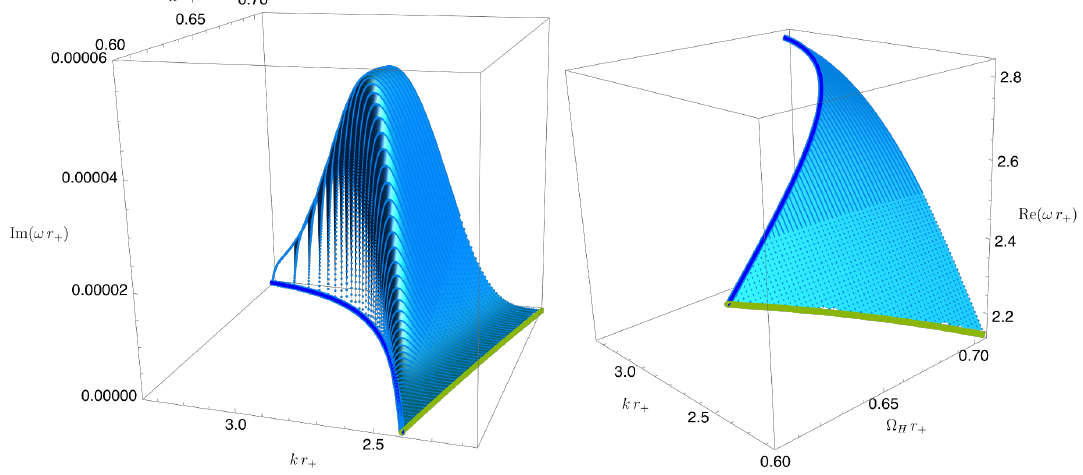
Figure 4 . Frequency for m = 2 unstable superradiant modes, as a function of parameters of Myers-Perry black strings. The instability is present (i.e. Im e Ω H | c = 3 / 5 , and e k ? ( e Ω H ) ≤ e k ≤ e k (0) ( e Ω H ) . The critical curve e k (0) ( e Ω H ) (and Im e ω = 0 ) was also computed independently in figure 3 and we show it as a continuous blue line in the Im On the other hand, the green curve represents the line e k ? ( e Ω H ) as defined parametrically in (4.12). It meets the merger blue curve at e Ω H | c = 3 / 5 . The Im